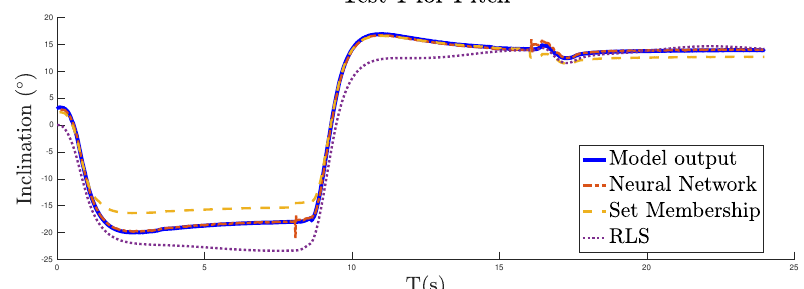
Figure 11. Test 1 input signal.